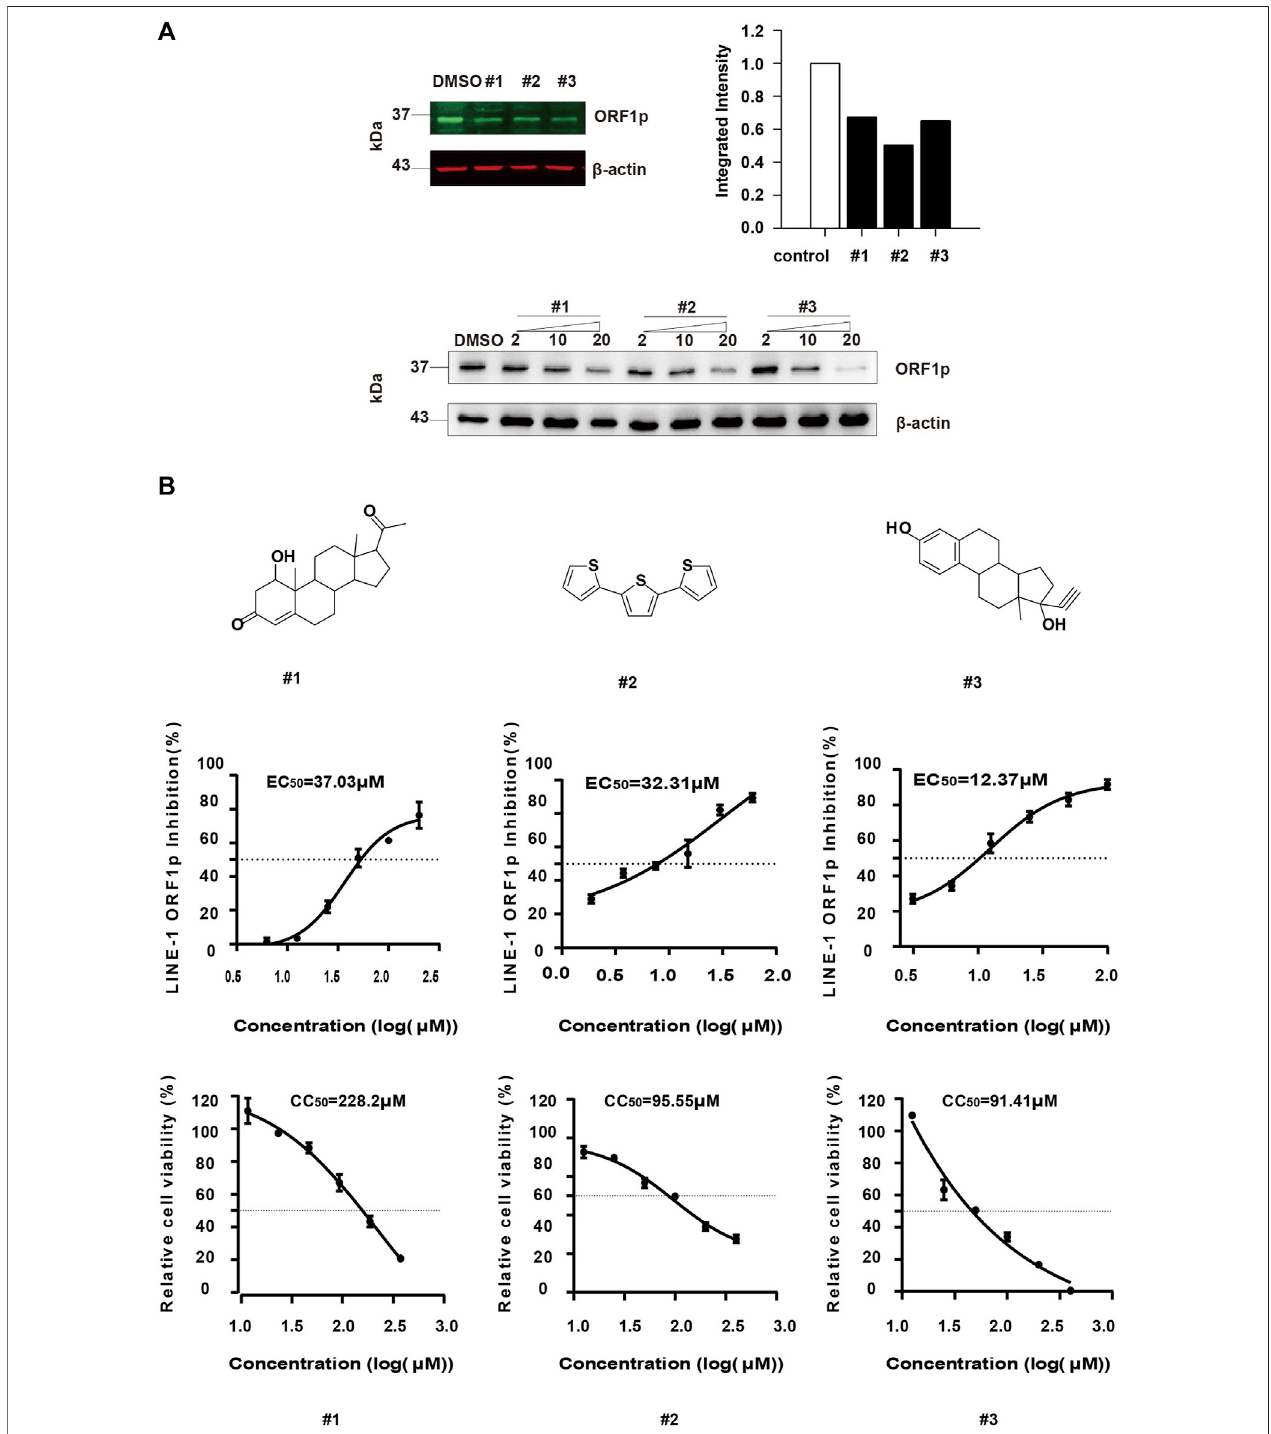
FIGURE 4 | Evaluation of the anti-ORF1p activity of the selected hits. (A) , The T-47D cells were treated with #1, #2 and #3 at different concentrations, and 48 h later, the ORF1p expression level was detected by immunoblotting assay. (B) , Determination of the EC50 and CC50 of the compounds. T-47D cells (15000/wells) were seededin96-wellplates,andthentreatedwiththeseriallydilutedcompound.After24 hincubation,theLINE-1ORF1pexpressionlevelwasdetectedbyICW.Toassess cellviability,T-47Dcells(1000/wells)wereseededin96-wellplates,andtreatedwiththeseinhibitorsasindicatedabove.TheCC50valuesweremeasured.Results shown are the average of three independent